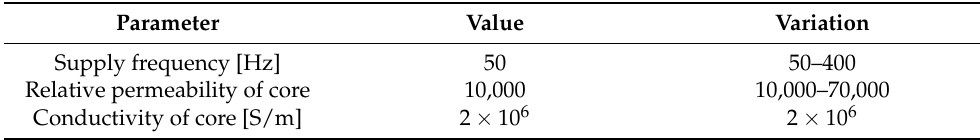
Table 2. Material parameters used for LVDT